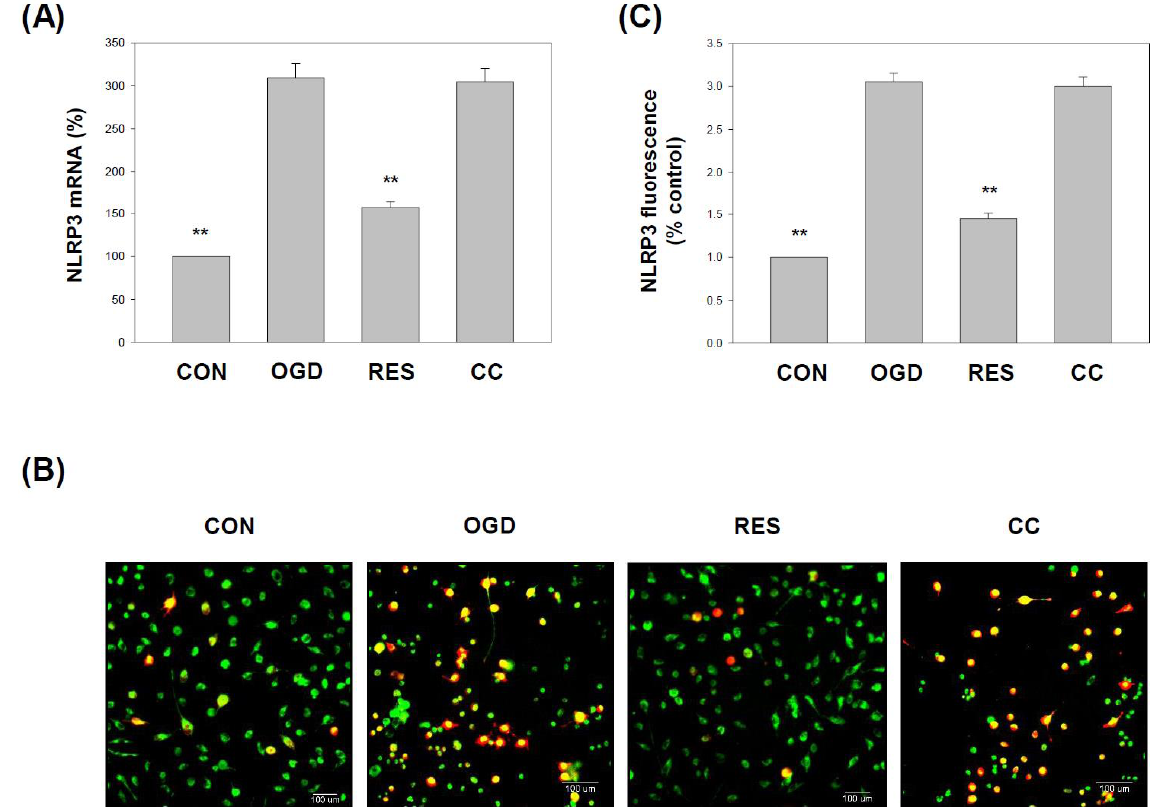
Figure 4. Resveratrol normalizes NLRP3 levels in OGD-induced cells in the 3D scaffold. The cell experiments under the scaffolds were divided into four groups, as described in Figure 1 and the methods section. ( A ) qPCR was used to analyze the NLRP3 mRNA level in each treatment group. Collect total RNA from the cells and reverse transcribe it into cDNA. Perform qPCR on the specified gene and normalize it to GAPDH expression. ( B ) Immunostaining of the cells was performed using anti-NLRP3 and anti-MAP2 antibodies. NLRP3 was visualized using the Avidin-Alexa Fluor ® 568 (red)-conjugated secondary antibody. MAP2 was visualized using Avidin-Alexa Fluor ® 488 (green)-conjugated secondary antibody. A representative image of three independent experiments is shown. Scale bar: 100 µ m. ( C ) The fluorescence intensity of the immunostaining was quantified. The value is expressed as a percentage of the transcript established in CON and the mean ± SEM value from three independent experiments. Specific comparison to the indicated SH-SY5Y cells with OGD ** p < 0.001 vs. cells with